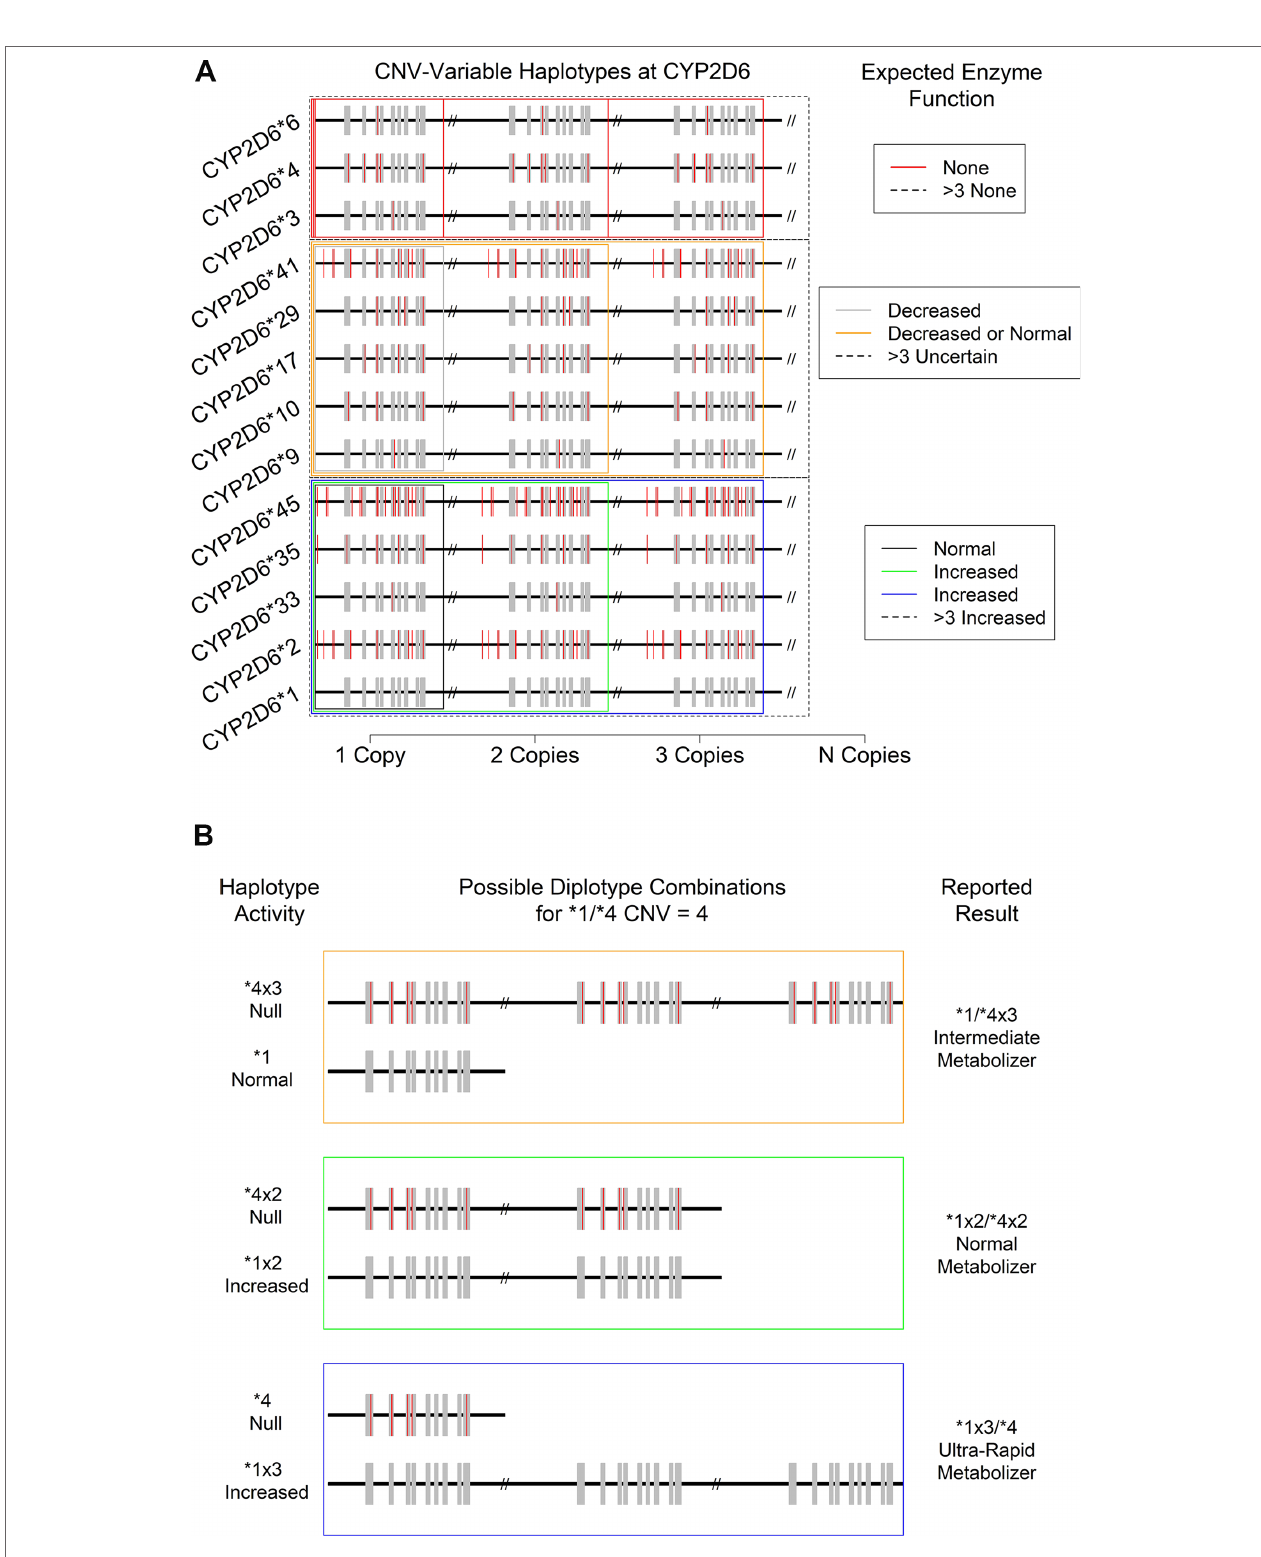
FIGURE 4 | Consequences of CYP2D6 gene duplication for (A) the activity level of 13 expected CNV-variable (duplicated) CYP2D6 alleles with known enzyme function. Not depicted: CYP2D6 *43 , which is also known to show duplications with an uncertain phenotype. (B) Individual haplotype (* allele) activity and overall metabolizer status of the “ *1/*4 , CNV = 4” specific patient result. Note that a copy-number of four introduces ambiguity in the reported metabolizer status due to technical uncertainty regarding which specific allele is